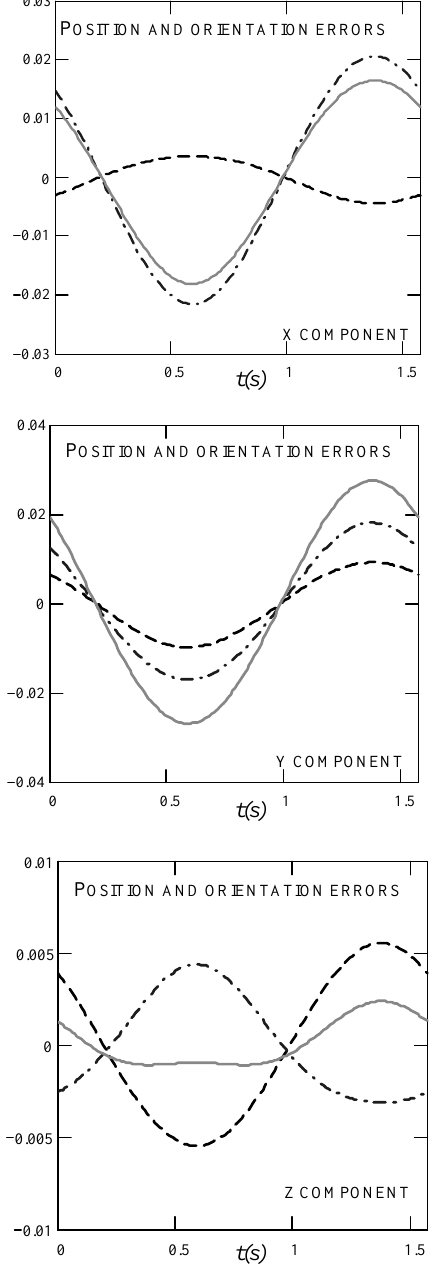
Fig. 2. Results of test case simulation: dimensionless errors [ err p ]. Dashed line: position error; dadot line: orientation error; solid line combination of position and orientation